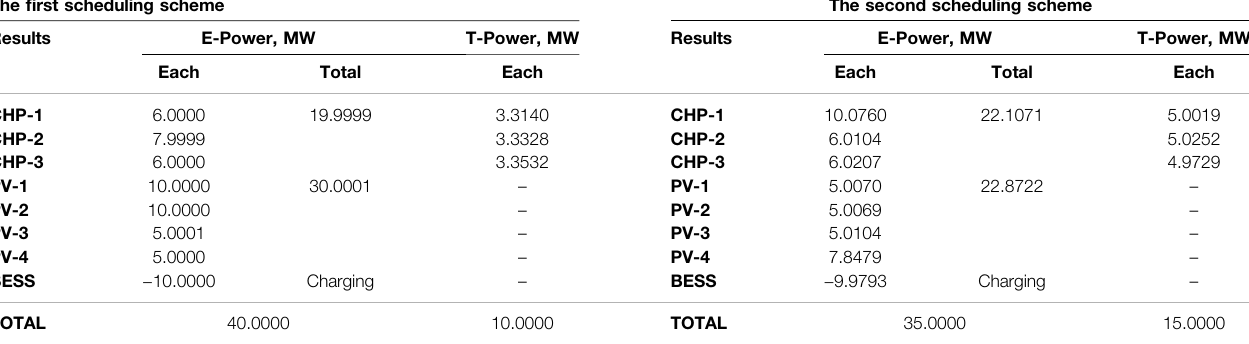
TABLE 5 | Results summary of the two scheduling schemes. The fi rst scheduling